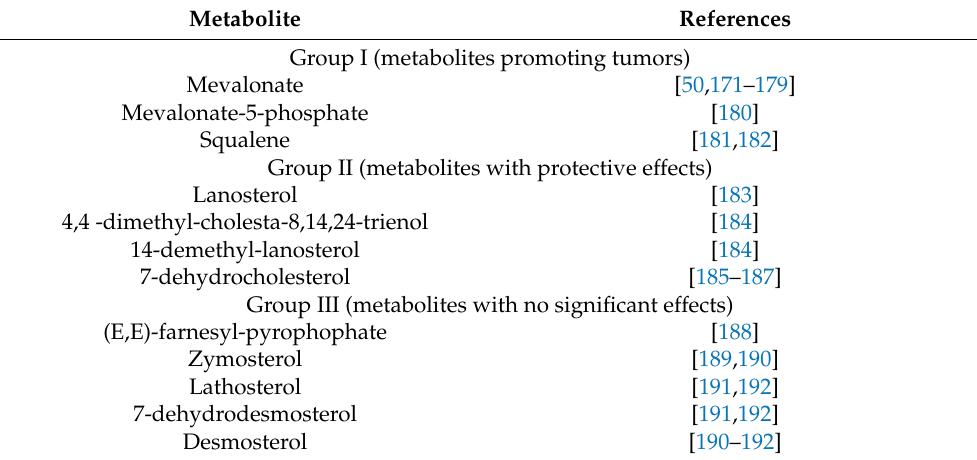
Table 4. Cholesterol precursors in their cancer-related